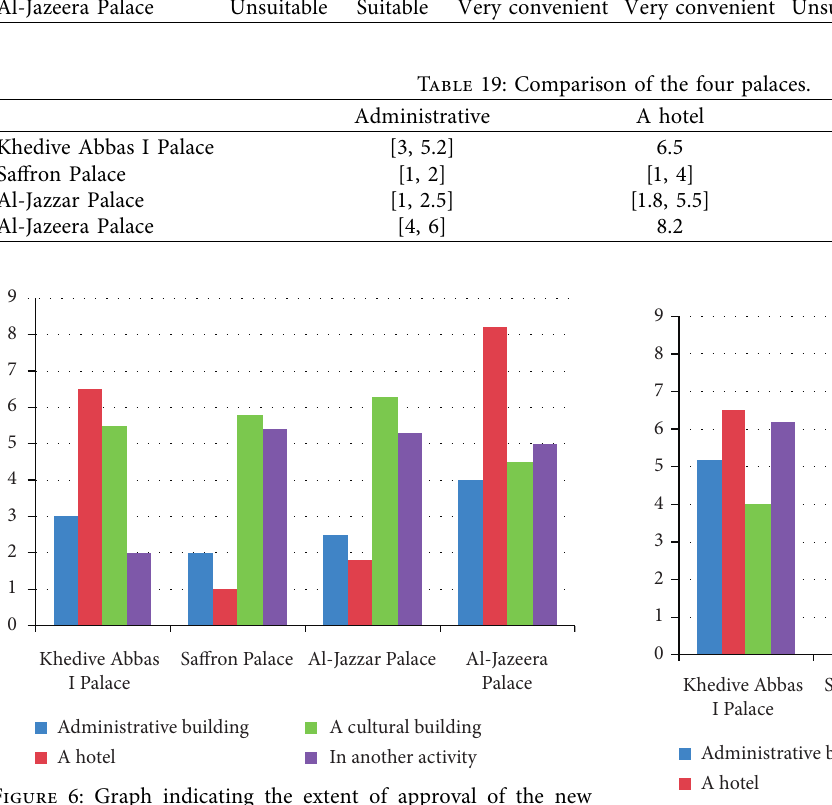
Figure 7: Flowchart indicating the extent of approval of the new activity of the building according to the viewpoint of the